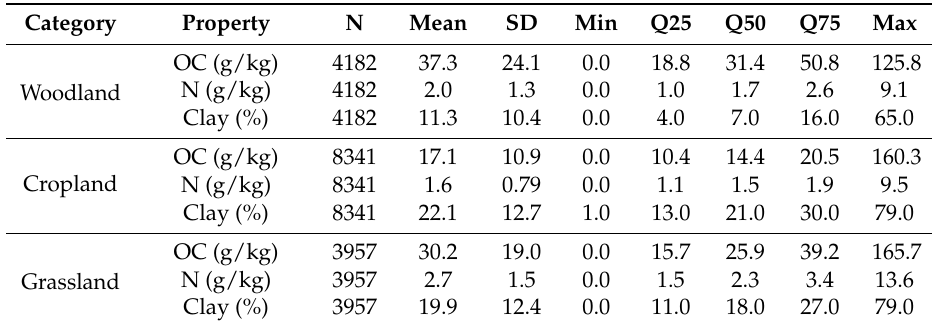
Table 1. Summary statistics of soil properties (organic carbon (OC), total nitrogen content (N), and clay) for the three soil